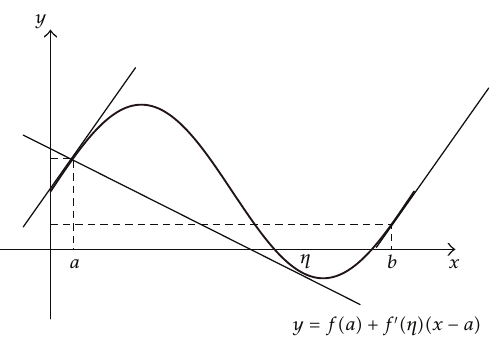
Figure 1: Geometric interpretation of Flett’s mean value